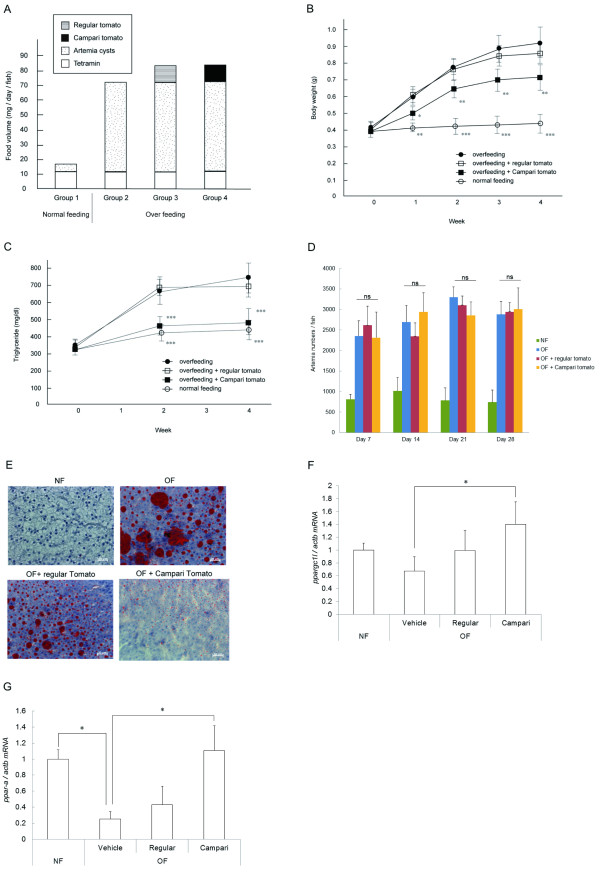
Assessment of body weight, plasma TG, and hepatic steatosis in zebrafish overfed with Campari and regular tomatoes. (A) Feeding condition of each group. Group 1, normal feeding; group 2, overfeeding of Artemia with Tetramin (vehicle); group 3, overfeeding with regular tomato; group 4, overfeeding with Campari tomato. Feeding experiments were conducted over 2 and 4 weeks. (B) Average body weight in each group during 4-week feeding experiments. Values are mean ± SD. Each group contained 20 samples. **P < 0.05; ***P < 0.01 vs. vehicle with overfeeding, black circles. (C) Change of plasma TG levels in the each group. ***P < 0.01 vs. vehicle with overfeeding, black circles. (D) Feeding behaviour assay counting Artemia numbers 90 min after feeding at 2 weeks. No significant difference was observed among vehicle, regular tomato, and Campari tomato administration in overfeeding groups. (E) Oil red O staining of liver sections. Campari tomato reduced the number and size of lipid droplets (red) compared with overfeeding and overfeeding regular tomato. (F and G) qPCR-assessed gene expression in the livers of DIO and normally fed zebrafish. Expression of ppar-ab (F) and ppargc1-like (G), a zebrafish homolog of human PPAR-α and PPARGC1 (PGC-1α, was normalized to actb expression. Values are mean ± SE (n = 5/group). *P < 0.05 vs. vehicle with overfeeding (OF).